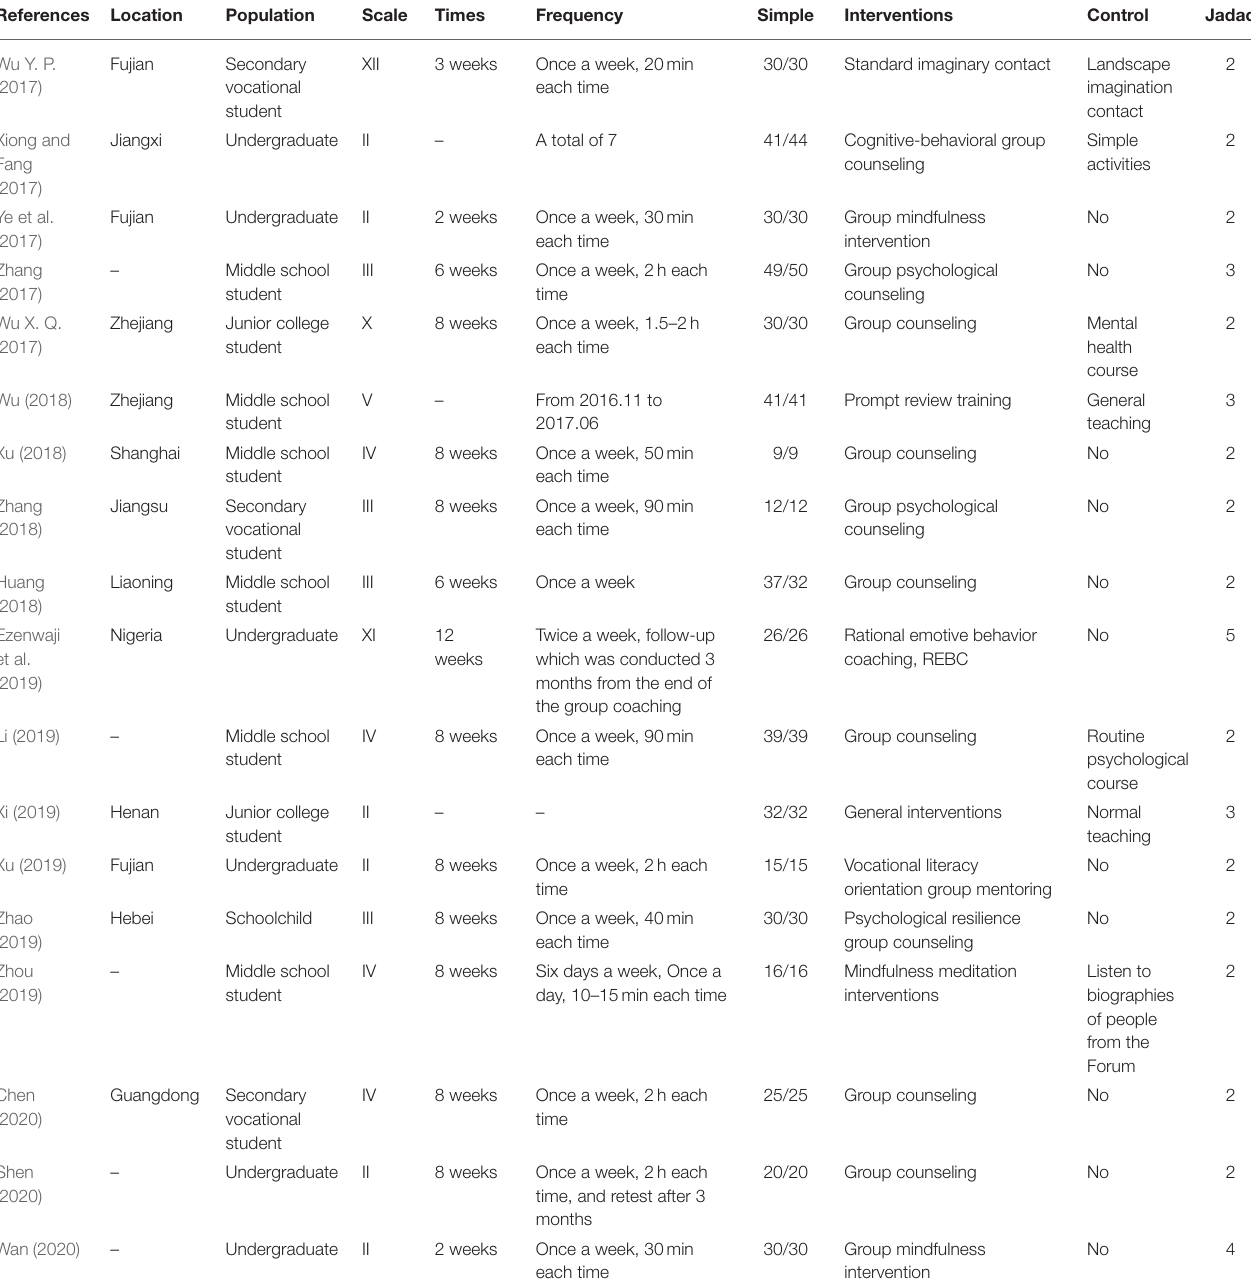
Subgroup analysis of intervention time showed that different intervention times had a significant intervention effect. The intervention group with the intervention period ≥ 8 weeks